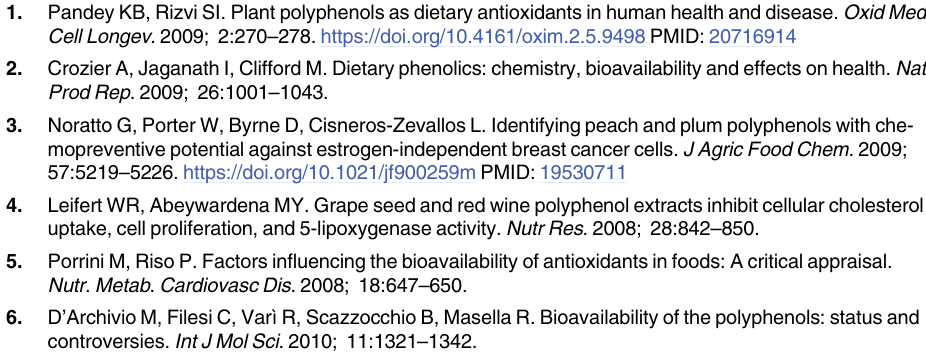
S1 Table. Concentration of caffeic acid in plasma collected after oral feeding and hydro- lyzed with sulfatase / β